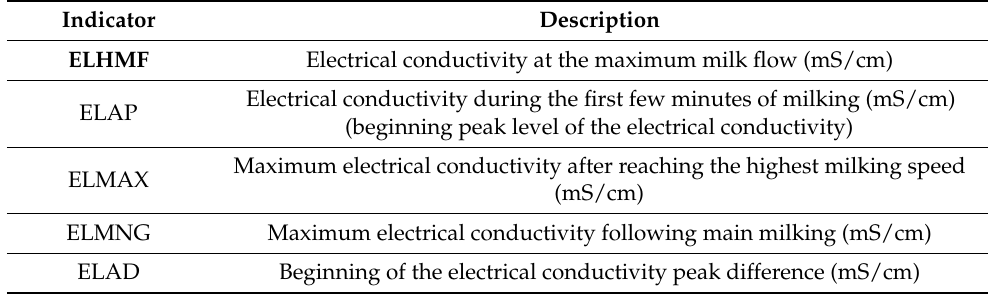
Table 1. A detailed description of the electrical conductivity